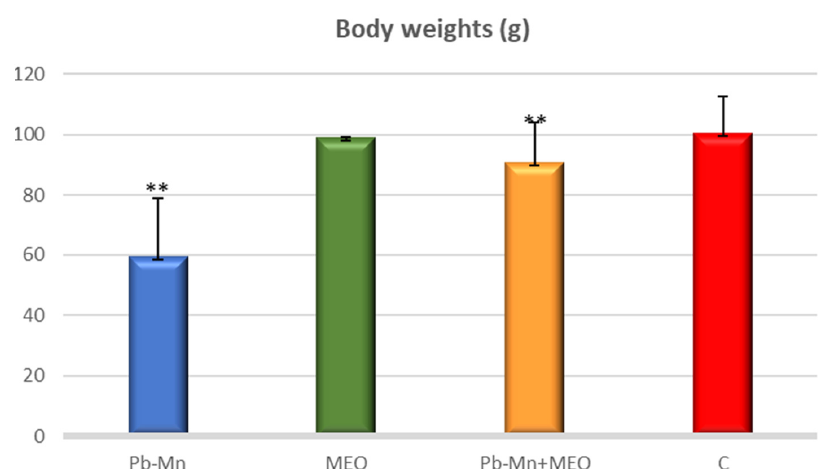
Figure 1. Effect of M. spicata essential oil on the body weight in rats intoxicated (Pb-Mn) Data are mean ±S.E.M. ** P<0.01, (Pb-Mn vs. C).